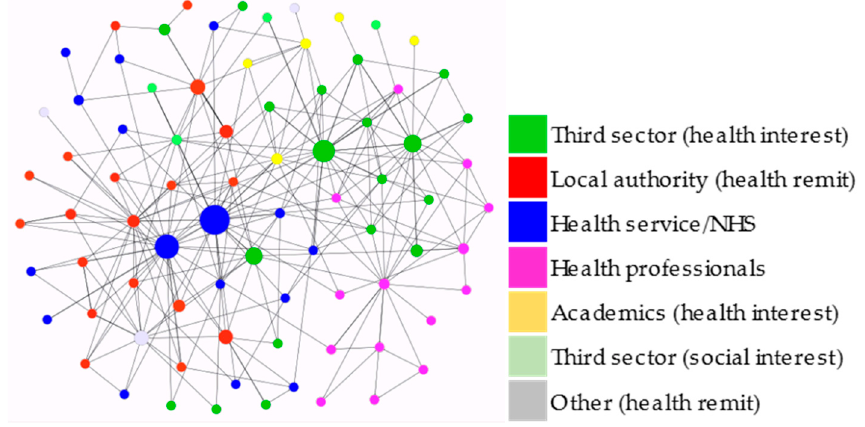
Figure 2. Network diagram of connections between health-focused actors (nodes are sized by betweenness